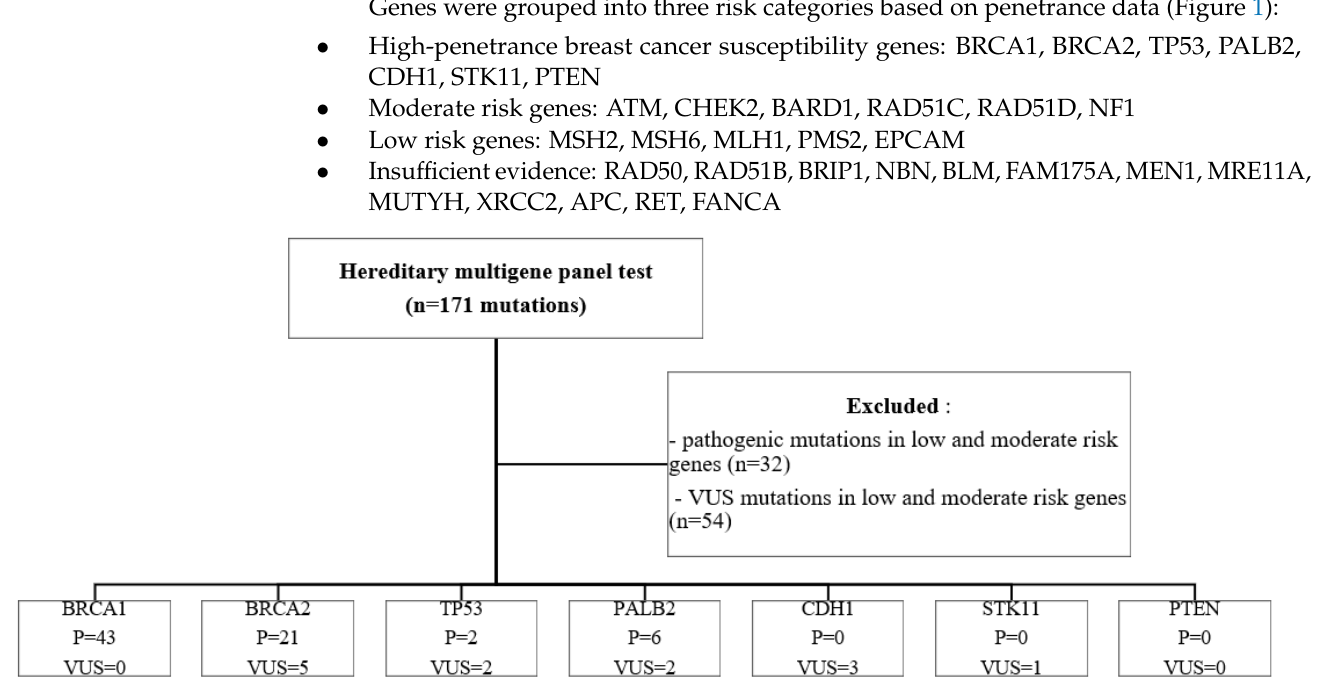
Table 2. Pathogenic BRCA 1 variants identified in the study group patients.